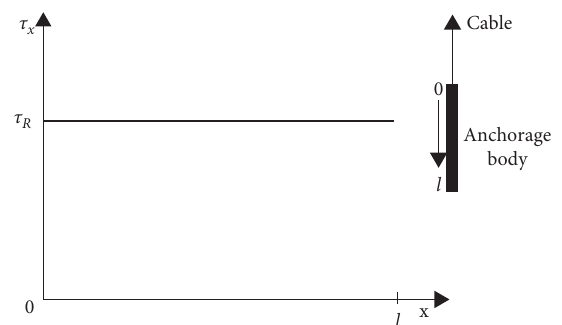
Figure 9: Uniform shear stress distribution (only includes the relative slip zone).